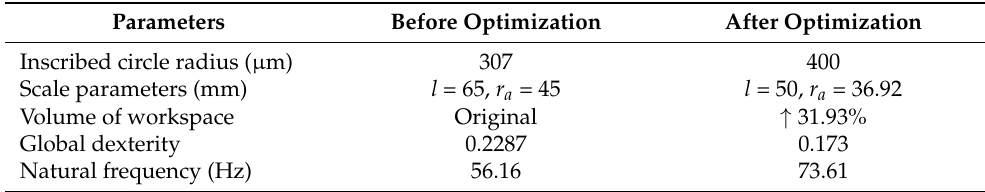
Table 5. Comparison of the scale parameters of micromanipulator, kinematic and dynamic perfor- mances before and after